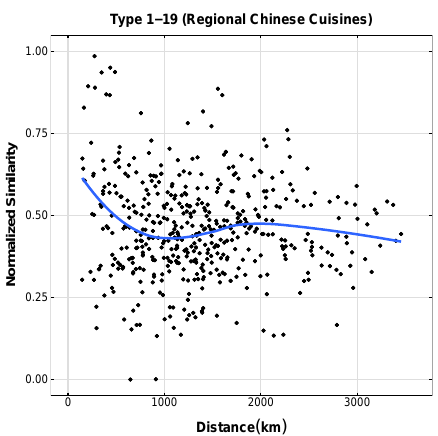
Figure 5. Scatter plot showing the relationship between cities’ similarities and their geographic distances (from the perspective of regional Chinese cuisines).